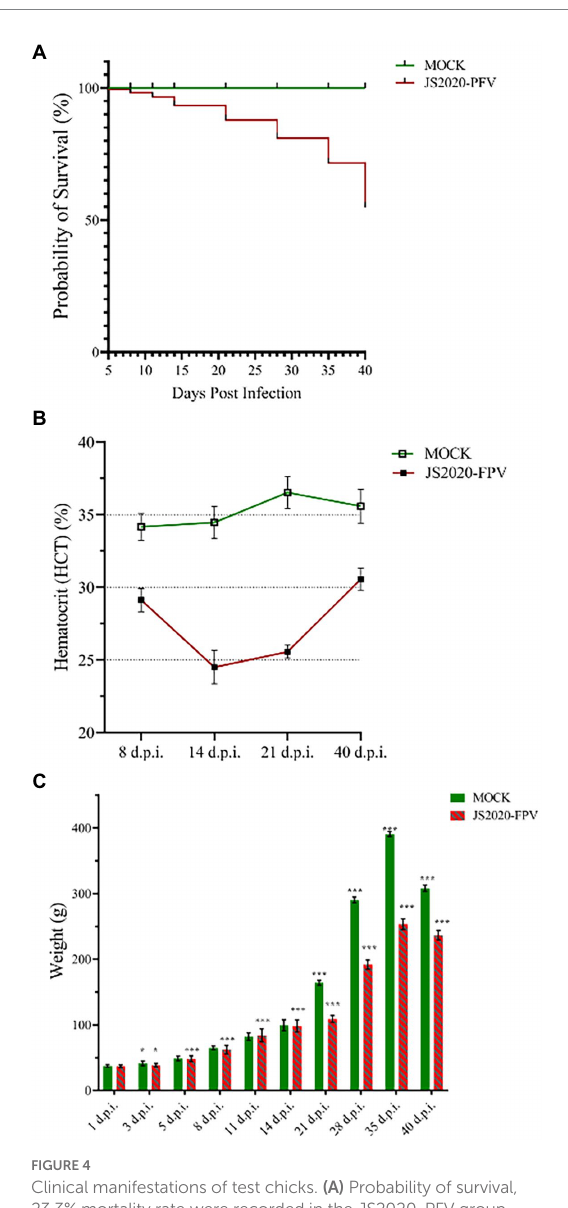
FIGURE 4 Clinical manifestations of test chicks. (A) Probability of survival, 23.3% mortality rate were recorded in the JS2020-PFV group (excluding normal dissection). No death occurred in the mock group. (B) Results of hematocrit (HCT; n = 4/group). The HCT of SPF chicks in the JS2020-PFV group was consistently lower than that of chicks in the mock group. In the JS2020-PFV group, it was lower than 27% from 14 d.p.i to 21 d.p.i. (C) Weight detection of experienced chicks showed average ± SD. Significant differences throughout the experiment are indicated by different labels next to the legend of each graph, * p < 0.05, *** p <